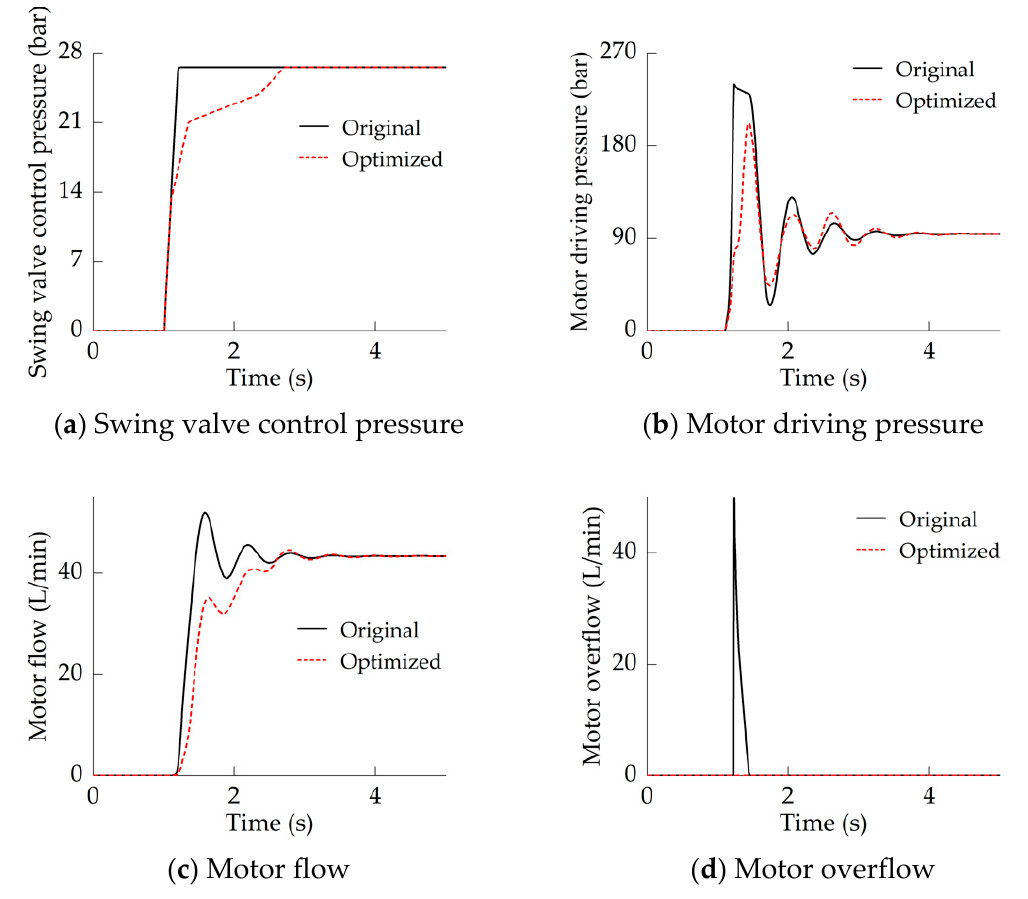
Figure 13. Motor acceleration characteristics (Minimum inertia).